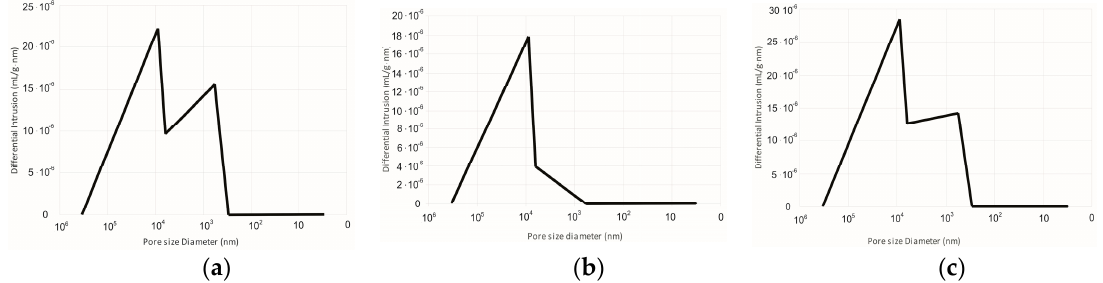
Figure 3. Chart presenting the layout distribution of the pore size of the material obtained by the salt-leaching method from 3% ( a ), 4% ( b ), and 5% ( c ) of butyric-acetic chitin co-polyesters 90/10. The mass ratio of inorganic salt to solution of BAC 90/10 in ethanol was 6/10.